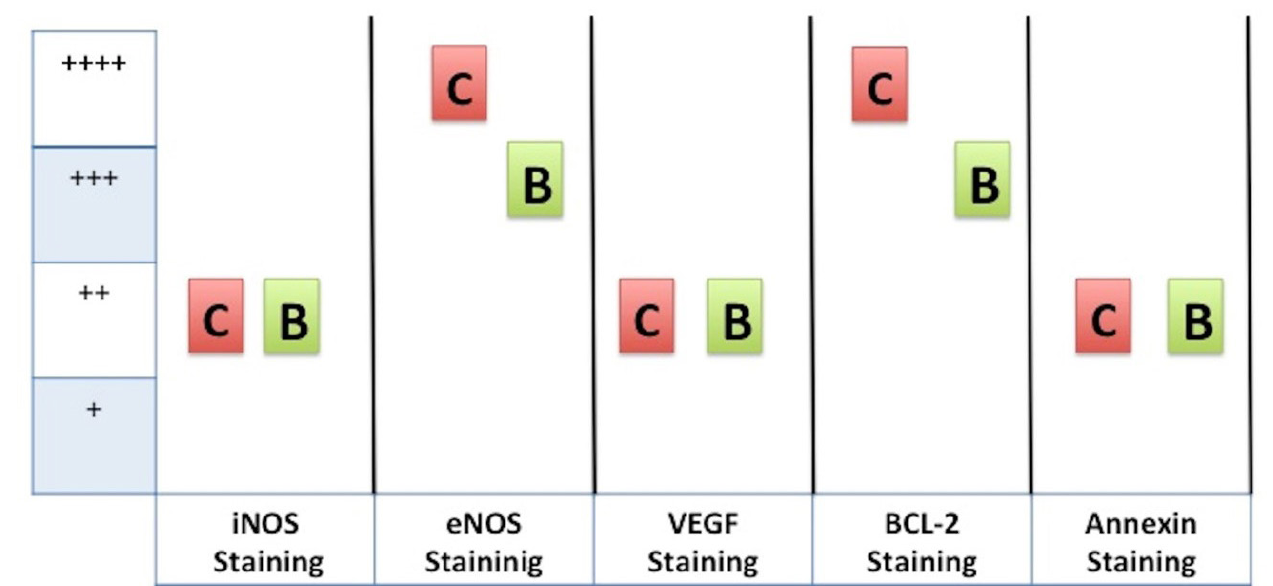
Fig. 3 - Immunohistochemical markers and median values of staining patterns for Custodiol and blood cardioplegia groups. C: Custodiol group; B: blood cardioplegia group.